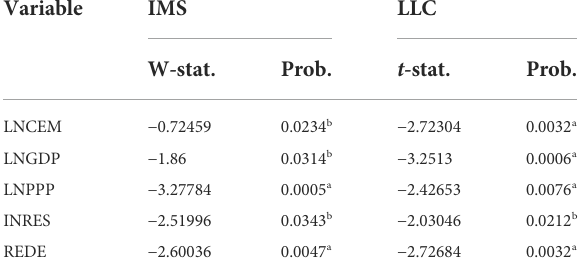
TABLE 4 IPS and LLC